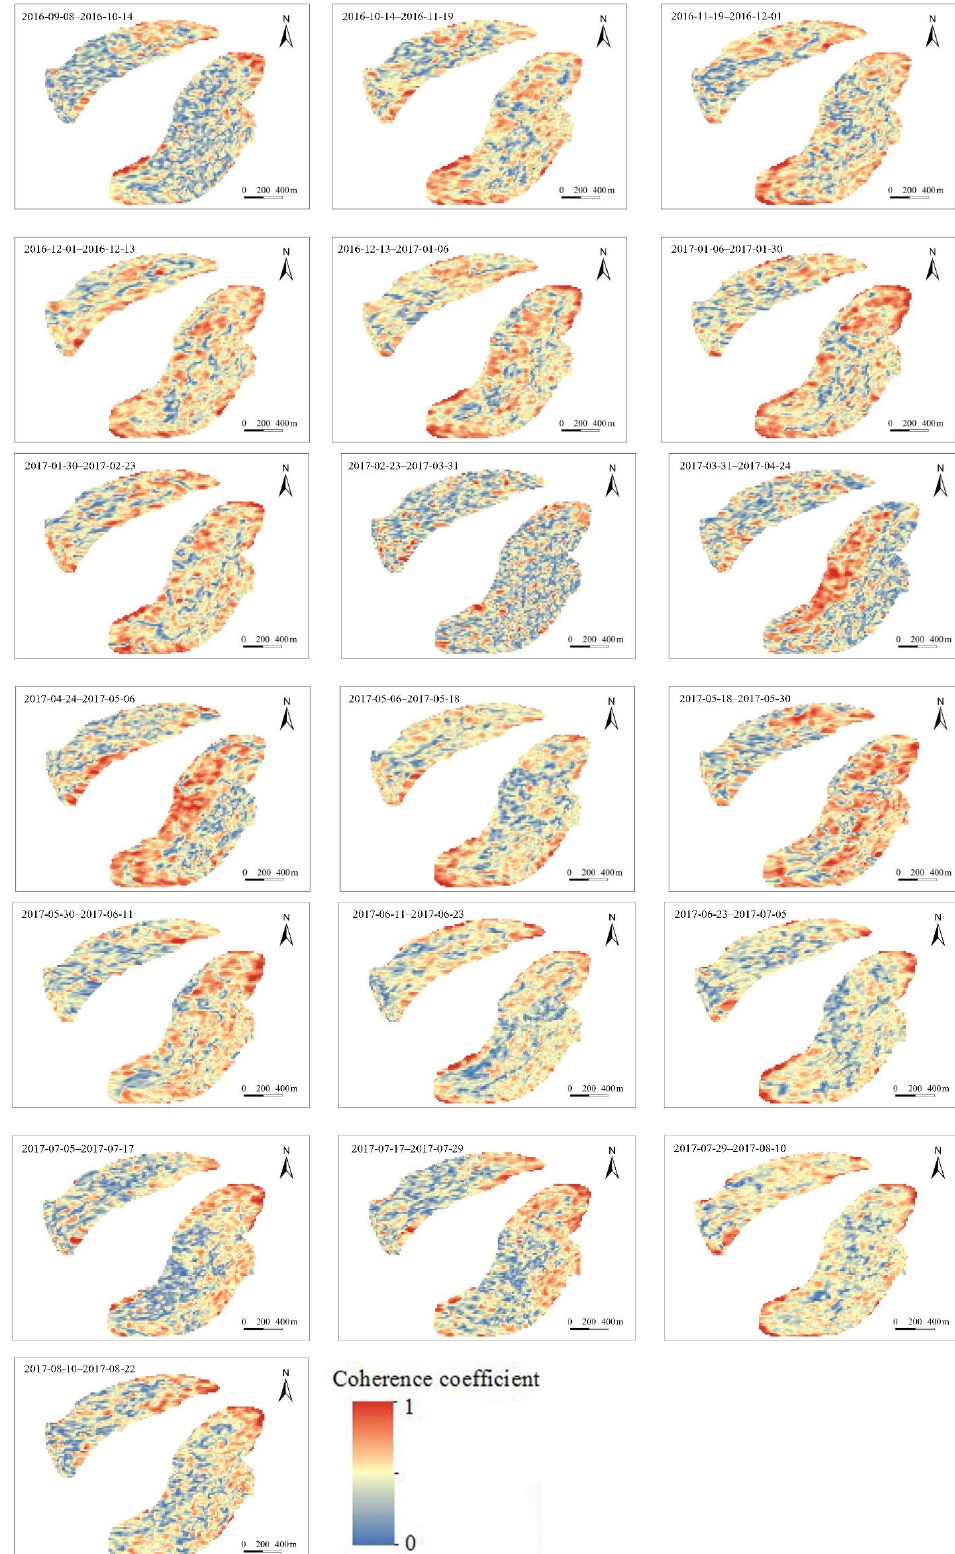
Figure A2. Coherence diagram of each descending image pair.